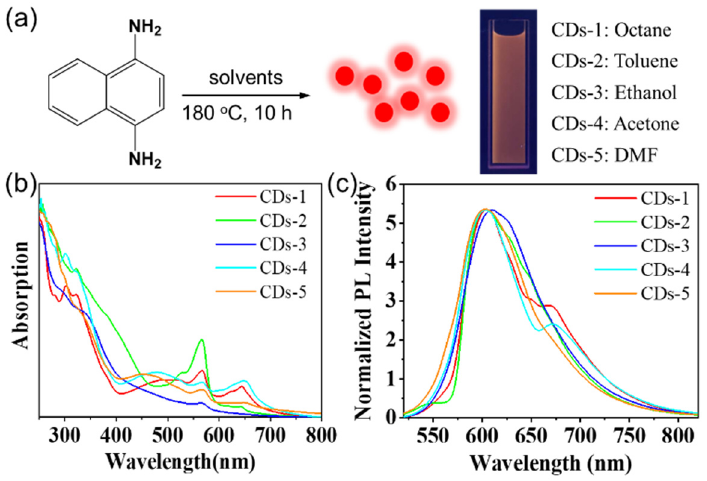
Figure 1. ( a ) Preparation of red-emitting CDs from 1,4-diaminonaphthalene. ( b ) UV/Vis absorption and ( c ) PL emission spectra of CDs (0.1 mg/mL) in